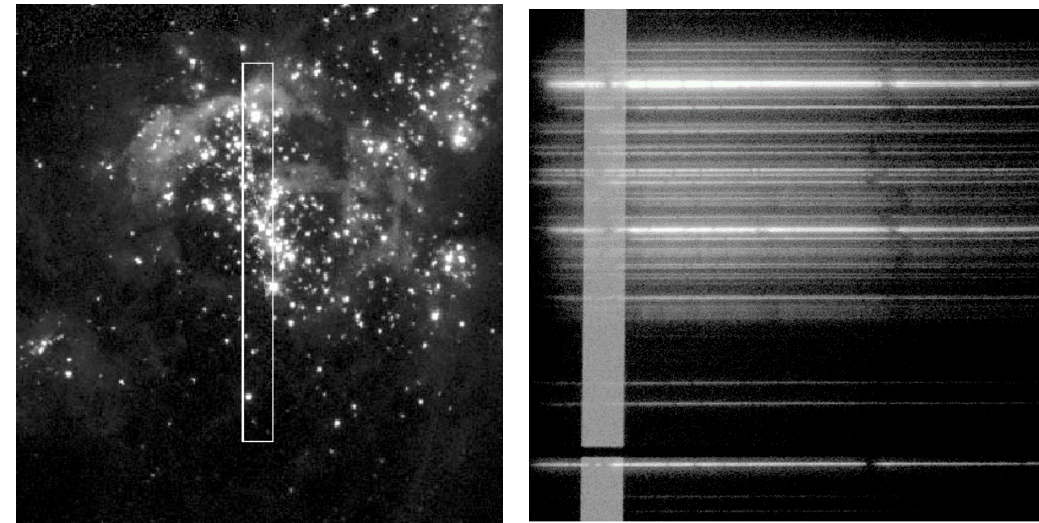
Figure 5. Left: the 2 ʺ - (corresponding to 8 pc) wide aperture of STIS superposed on a U image of NGC 604. Right: the STIS spectral image of OB stars in NGC 604, showing the individually resolved spectra. The vertical stripe to the left is geocoronal Ly- α . From [20].